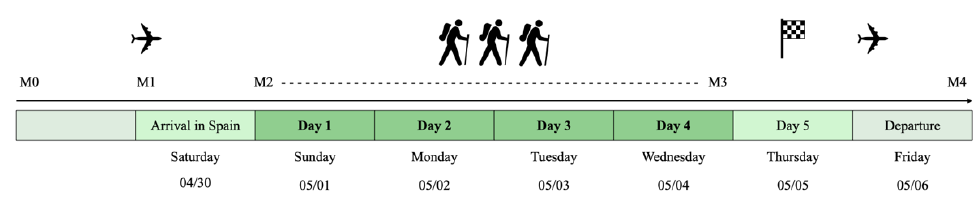
Figure 1. Study design: measurement (M)0, medical examination; M1, questionnaires (World Health Organization (WHO)-5 and Problem Areas in Diabetes (PAID) scale); M2-M3, hiking tour and continuous glucose monitoring (CGM); M4, questionnaires (WHO-5 and PAID).